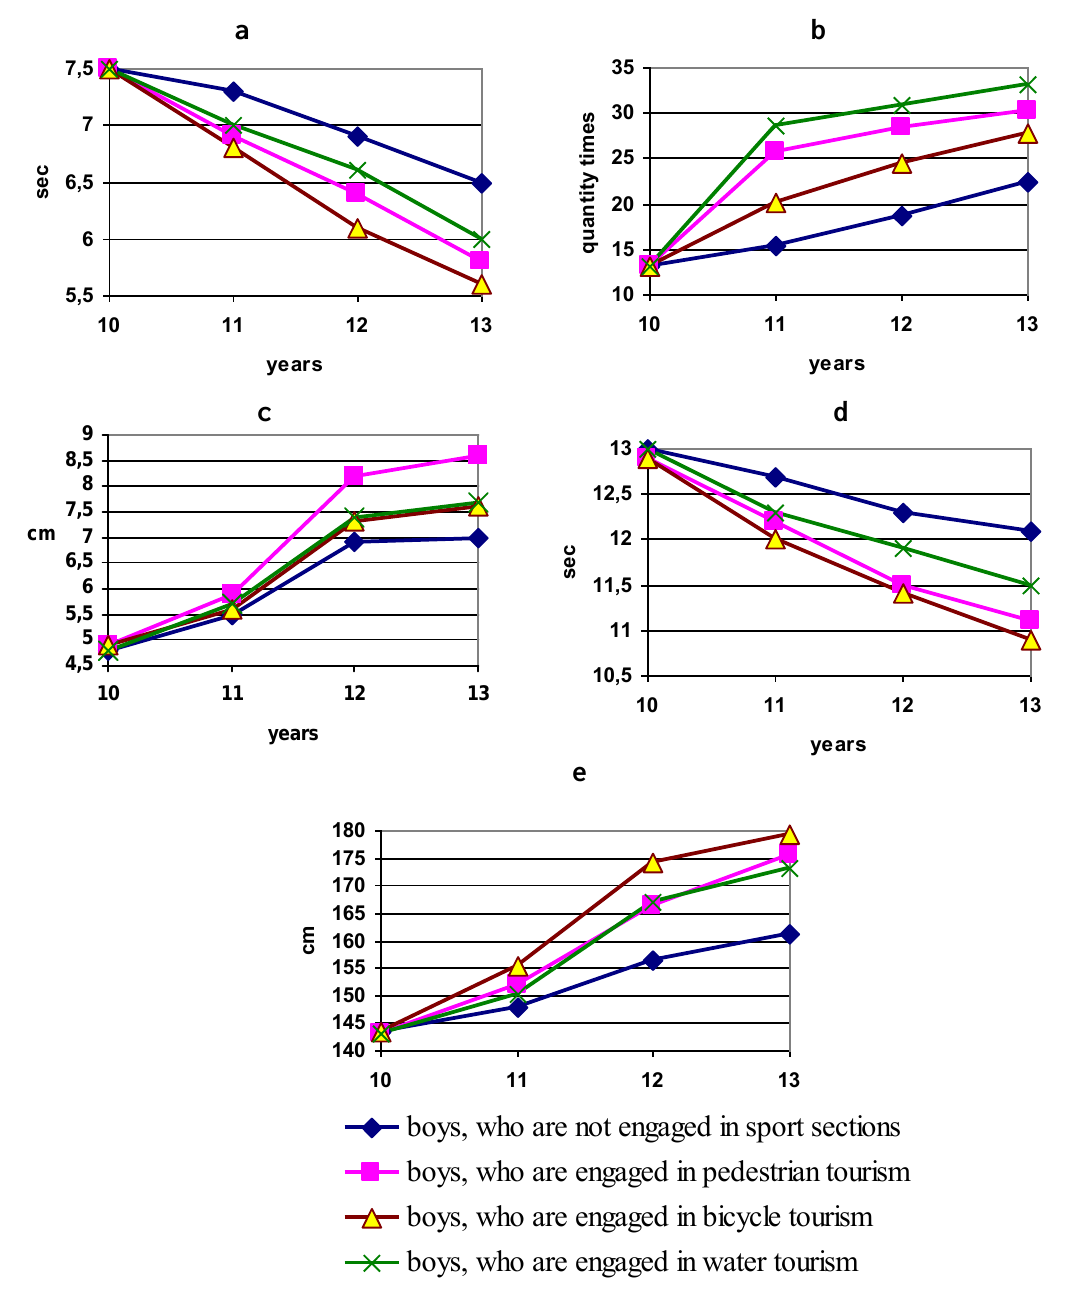
Fig. 1. Physical qualities indices of boys aged 10-13 from different experimental groups (n 1 =n 2 =n 3 =n 4 =18): a) 30 meters run; b) flexing and extension arms support, lying on the floor; c) forward trunk flexion from